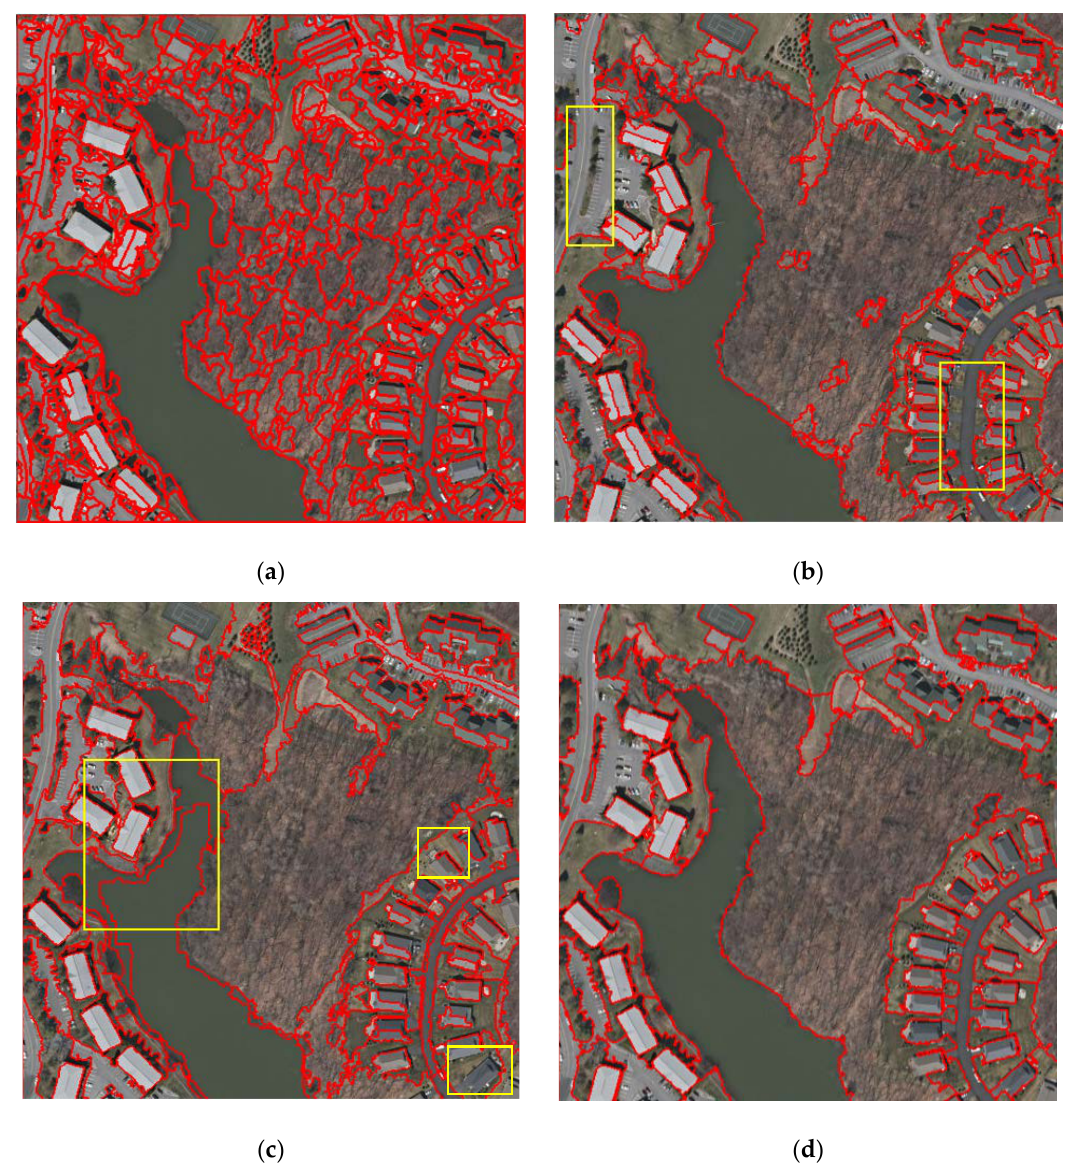
Figure 9. Segmentation results produced by different methods for the Albany QuickBird image (T1): ( a ) WTS; ( b ) MS; ( c ) MRS; ( d ) MMHS.